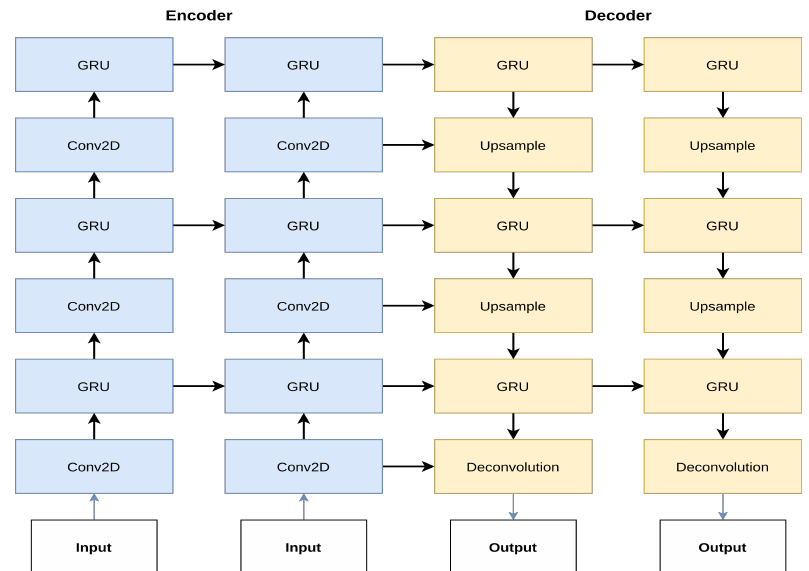
Figure 2. Diagram of the convolutional gated recurrent unit model (ConvGRU) with three GRU units. Sequences are downsampled using convolutions (Conv2D), using a kernel size of 3 and a stride of 1, 2, 2 (bottom to top layer). Upsampling is done using transpose convolutions using a kernel size of 4 and a stride of 1, 2, 2, respectively, with all filter sizes being 64, 96, 96. This figure shows the model architecture when predicting a sequence of length 2. Figure was adapted from